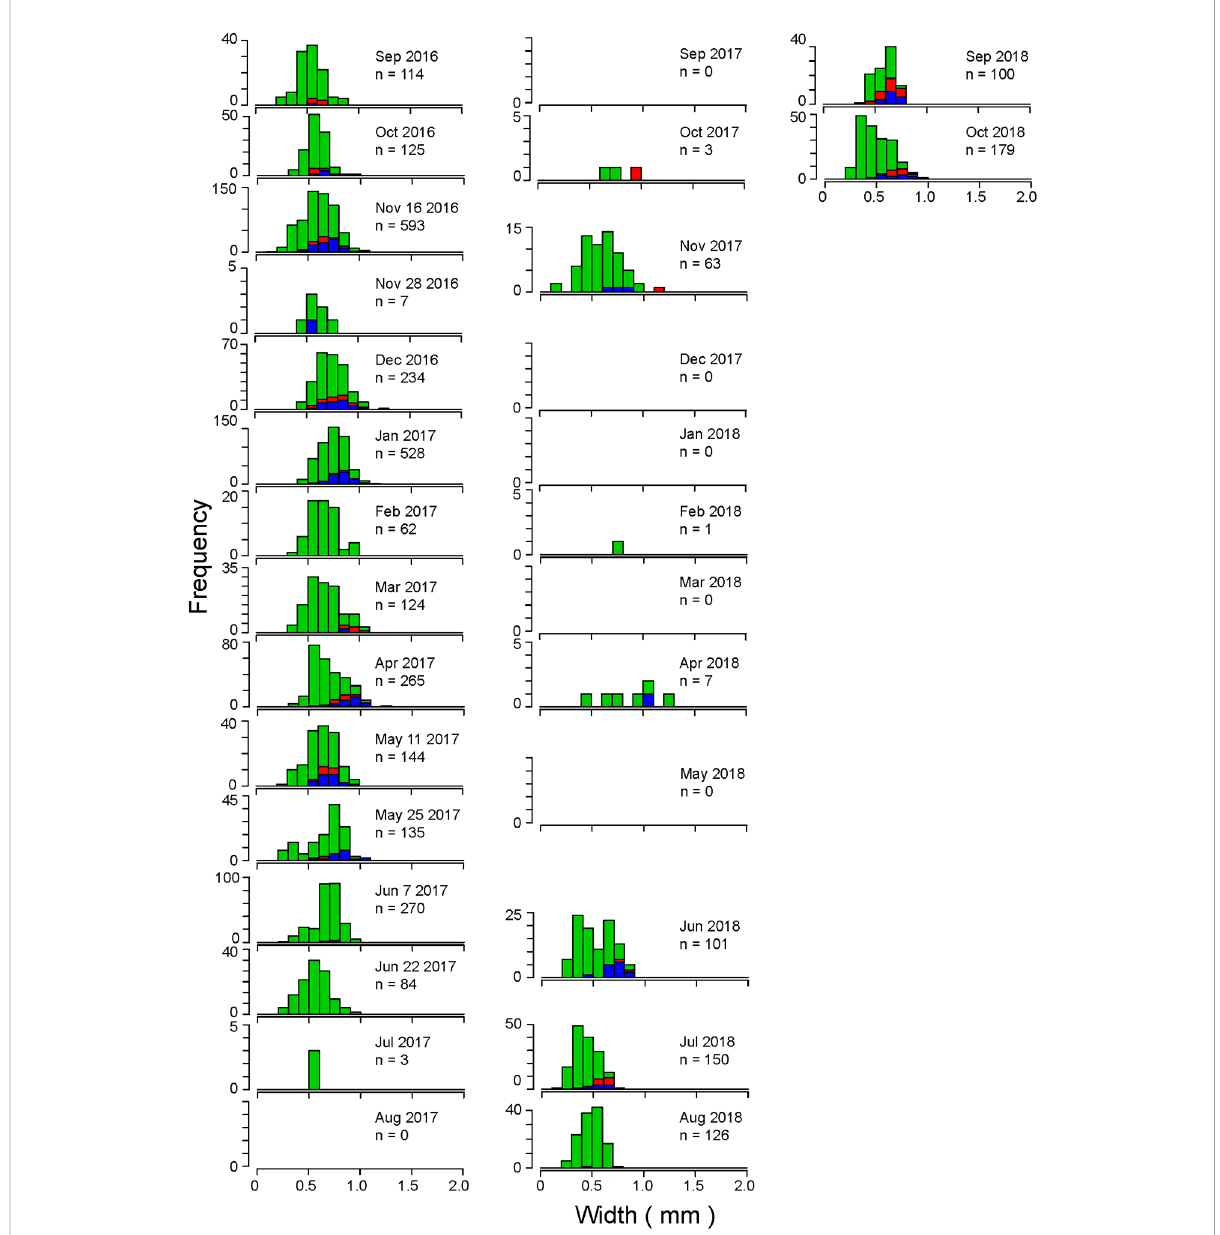
FIGURE 6 Size frequency distributions of the maximum width of the thoracic segment of C. aff. teleta at Stn C from September 2016 to March 2018 and at Stn C ′ from April 2018 to October 2018 in Gamo Lagoon. Red: females, blue: males, green: immature